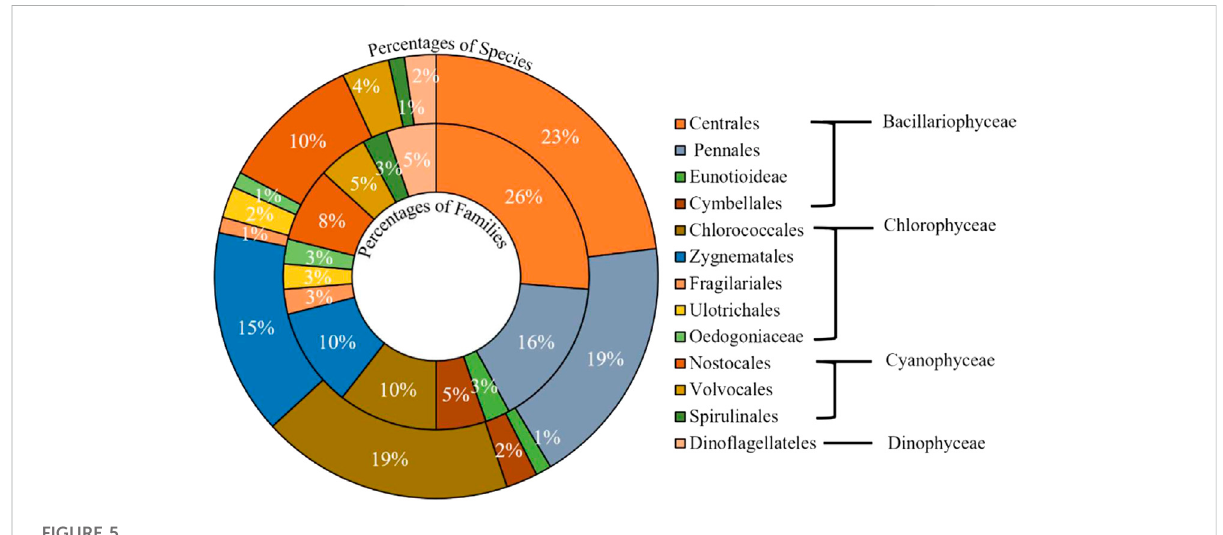
FIGURE 5 Diversity of Phytoplankton in the estuarine waters of Bangladesh.